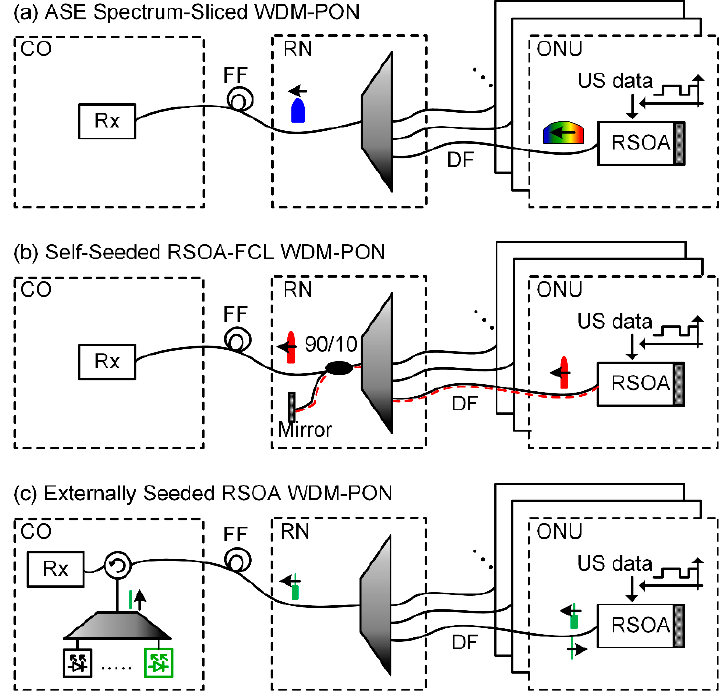
Figure 1. Wavelength division multiplexed passive optical network (WDM-PON) topologies with reflective semiconductor optical amplifier (RSOA) based colorless upstream (US) transmitters: ( a ) Amplified spontaneous emitter (ASE) spectrum-sliced transmitter: the US signal is directly modulated on to the ASE of the RSOA. The WDM filter at the remote node (RN) passes only the assigned sub band from each RSOA at the optical network units (ONUs); ( b ) Self-seeded RSOA-FCL (fiber cavity laser): a Fabry-Perot cavity indicated by the red dashed lines is formed between the RSOA and a mirror at the RN. The cavity is embedded in the distribution fiber (DF) of the PON; ( c ) Externally seeded RSOA: a laser at the central office (CO) seeds the RSOA at the ONU. The RSOA encodes the US signal onto the seed laser line. In all case, the ONUs are connected by the DF to the RN. The RN consists of the WDM filter and it is connected to the CO through the feeder fiber (FF).